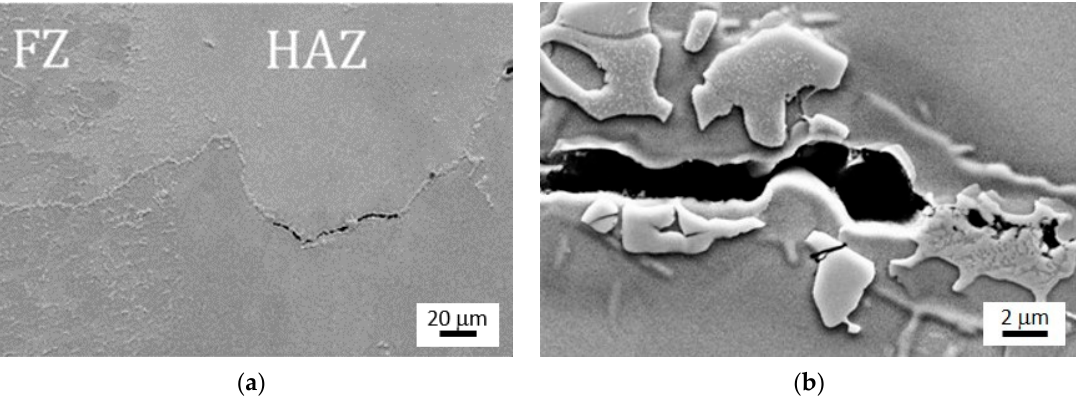
Figure 15. ( a ) Film along crack in HAZ from 9 mm thickness sample mould O cross-section. ( b ) Enlargement of crack